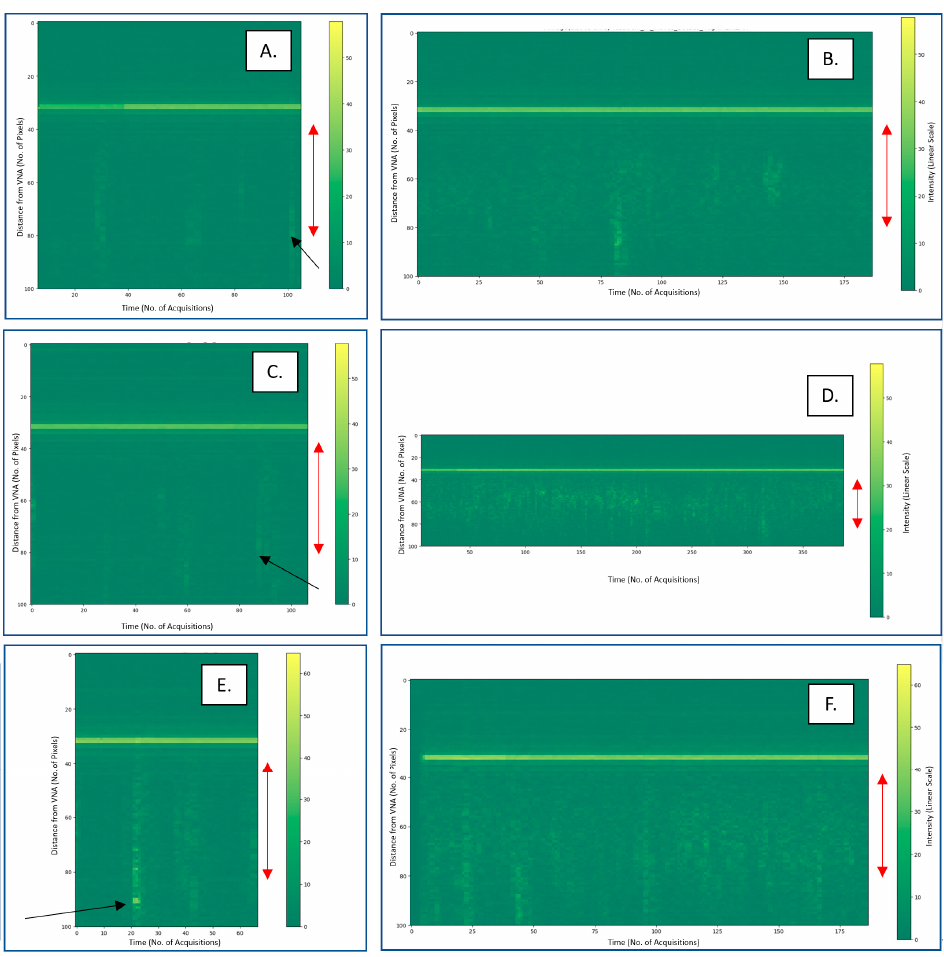
Figure 5. X-band intensity plots of irregular wave reference acquisitions (Left) and test acquisitions (Right). Nine centimetre irregular wave conditions for reference ( A ) and test ( B ) (Top). Test = 40 g/m 2 of plastics bottles inside tank (2 bottles/m 2 ) (Middle). Nine centimetre irregular wave conditions for reference ( C ) and test ( D ) conditions. Test = 20 g/m 2 of plastic foam cylinders (20 cm long) inside tank (Bottom). Seventeen centimetre irregular wave conditions for reference ( E , F ) conditions. Test = 10 g/m 2 of plastic inside tank (1.5 lids/m 2 ). Peak on intensity from the lip of the bridge by radar set-up can be seen across all figures. Colour—Intensity on a linear scale. Black arrow indicates a feature of interest. Red double arrow indicates the region of interest for the